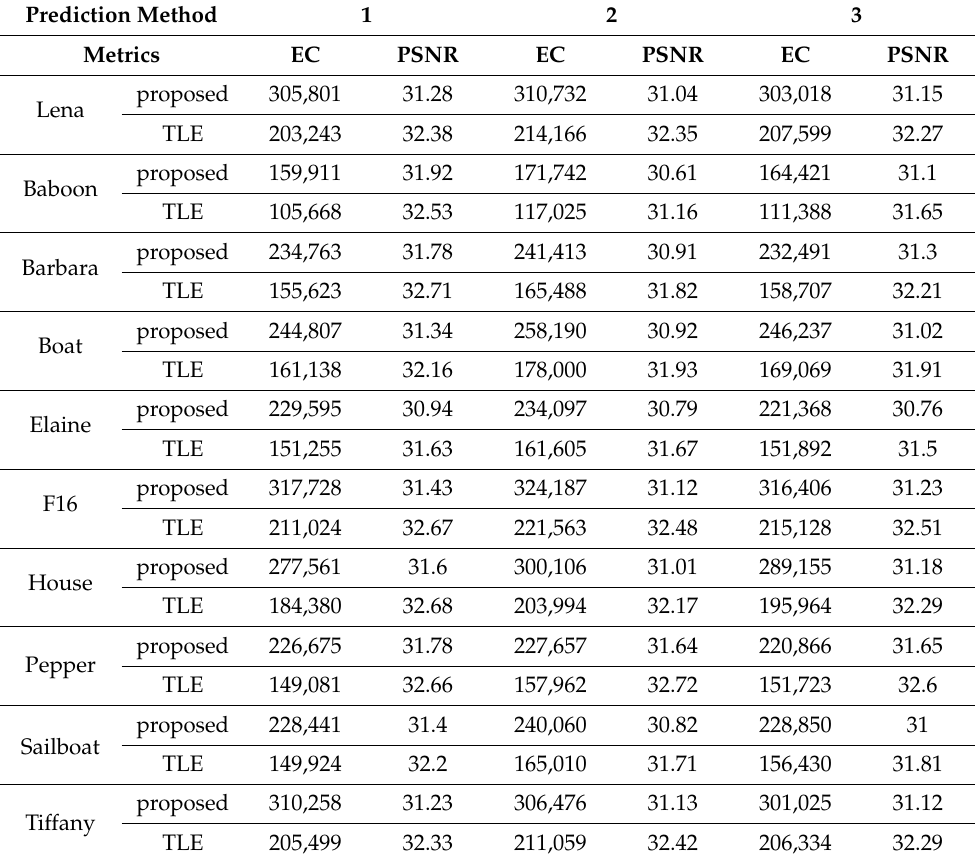
Table 5. The comparison of embedding EC and PSNR values by the proposed triple-RDH method and TLE method with 10 standard images on the three predictor